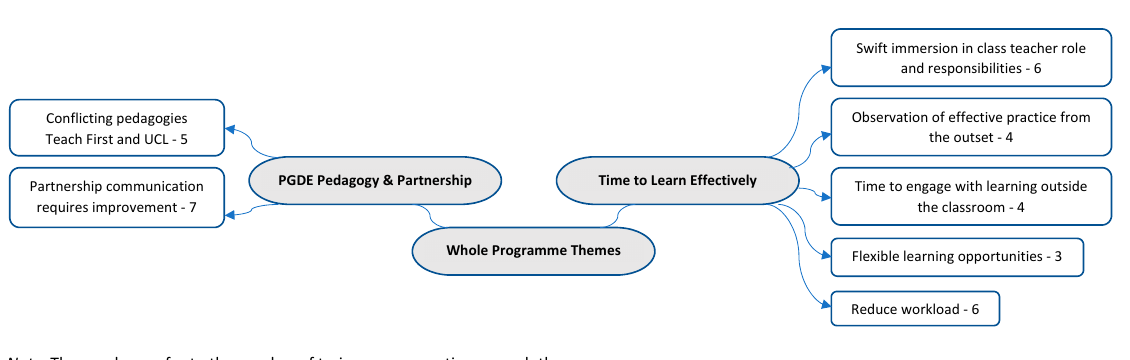
Figure 1. Programme-level themes (Source: Author, 2023)